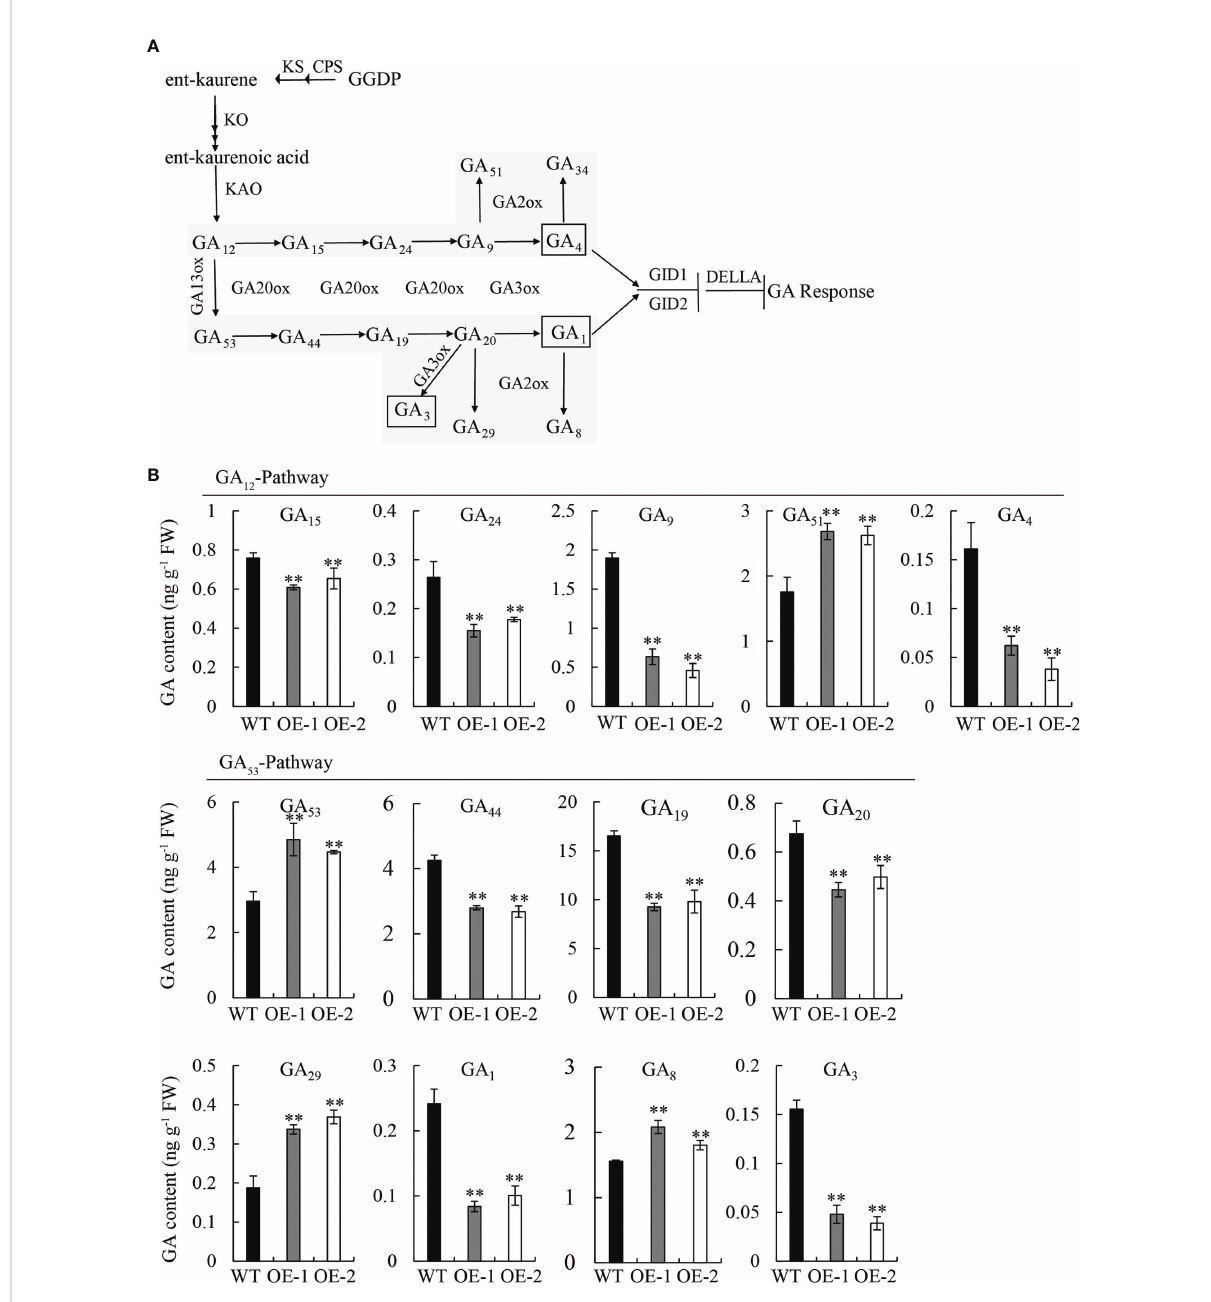
FIGURE 5 Measurement of endogenous GA in seedlings of the WT and OE lines. (A) Comparison of major gibberellin (GA) biosynthetic pathways in plants. (B) Content of GA species in the GA 12 -pathway and GA 53 -pathway. FW, fresh weight. Student ’ s t-tests were used to determine statistical signi fi cance. FW, fresh weight; error bars indicate ± SE (n = 3). Double asterisks indicate signi fi cant differences at P ≤ 0.01 compared with the WT in Student ’ s